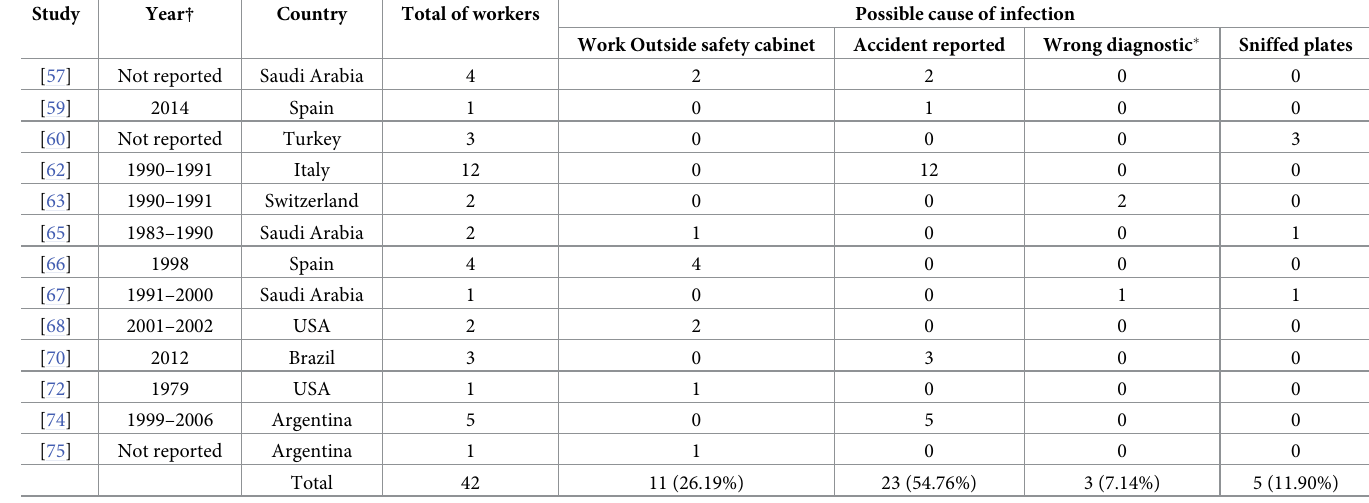
Table 4. Types of exposure associated with occupational transmission of Brucella spp. reported by infected laboratory workers.